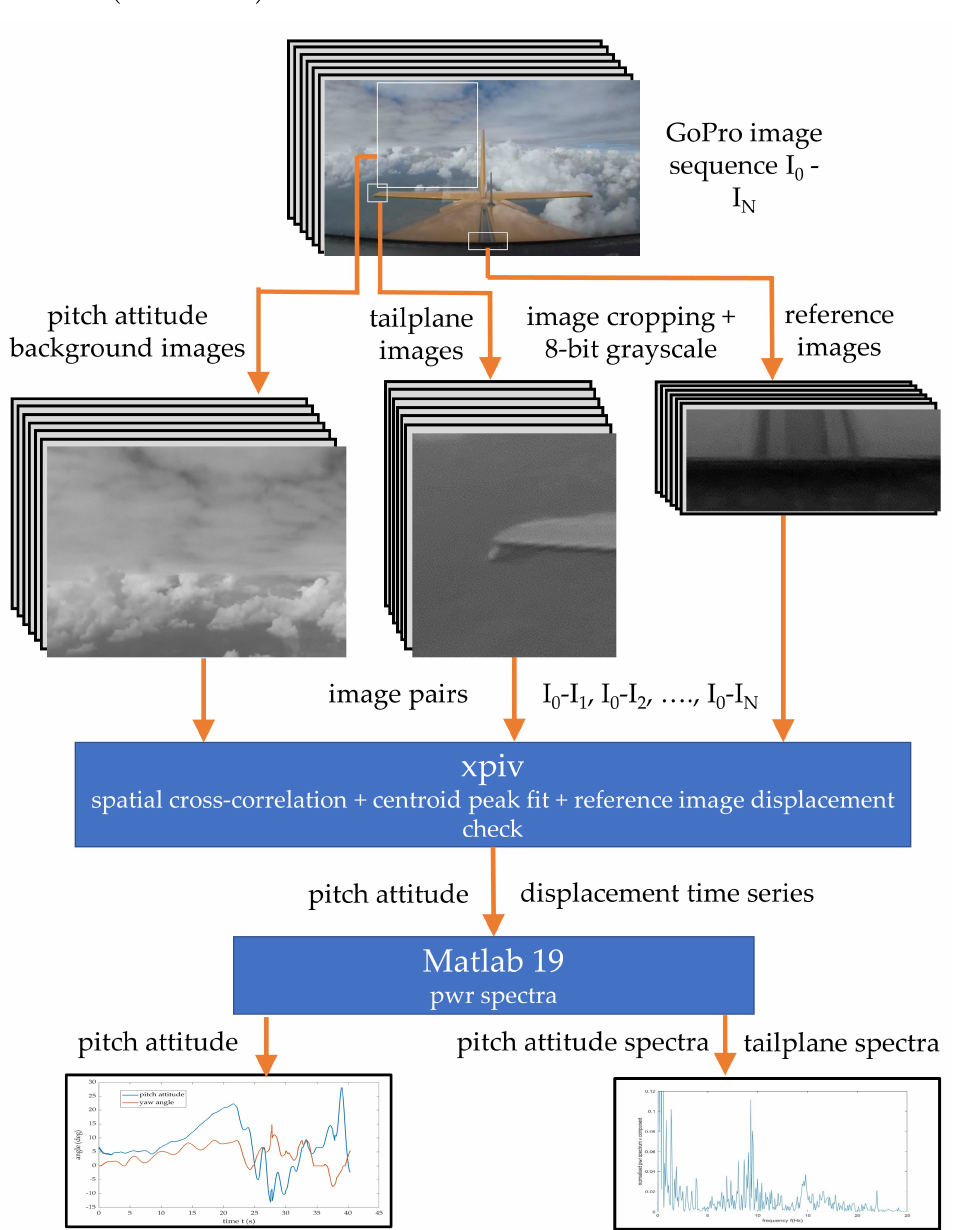
Figure 5. Data processing approach to tailplane, canopy rail reference and pitch attitude